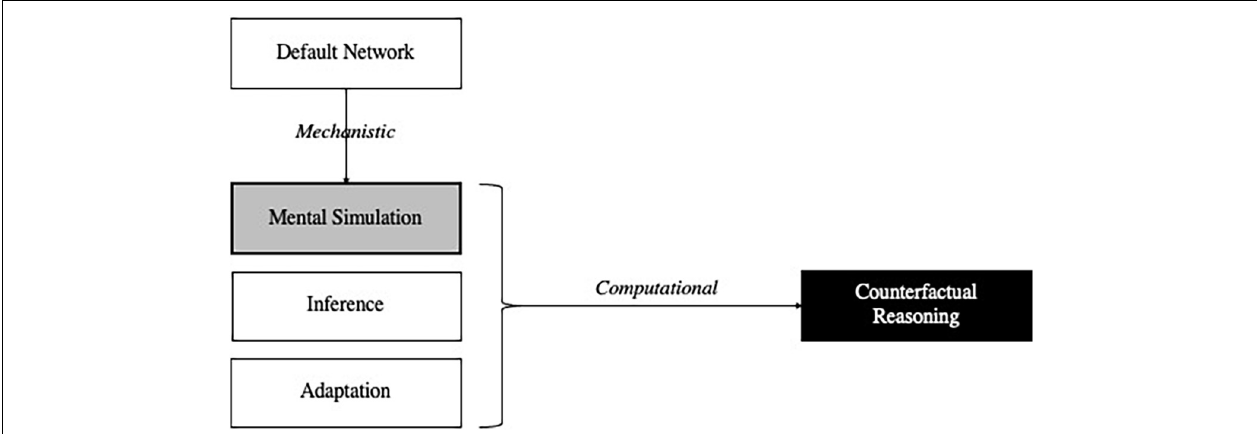
FIGURE 2 | Computational and mechanistic explanations involved in counterfactual reasoning. Mental simulation (gray box) both contributes to the computational explanation of counterfactual reasoning (black box) and is mechanistically explained by the activation of the default network.